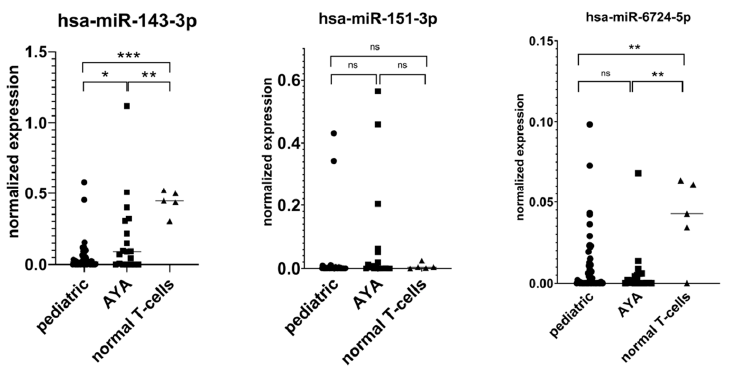
Figure A1. RT-qPCR validation of miRNA-seq results: * p < 0.05; ** p <0.01; *** p < 0.001; ns (not significant).